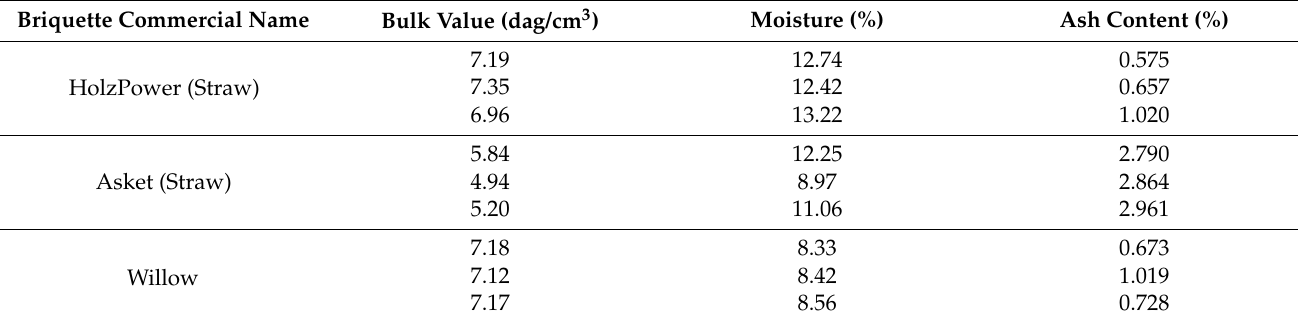
Table 2. Breakdown of parameters for respective